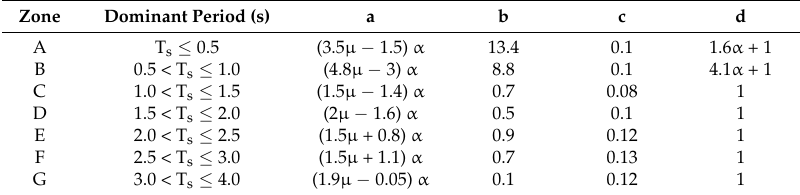
Table 2. Parameters involved in Equations (6) and (7), corresponding to seismic zones A to G. Zone Dominant Period (s) a